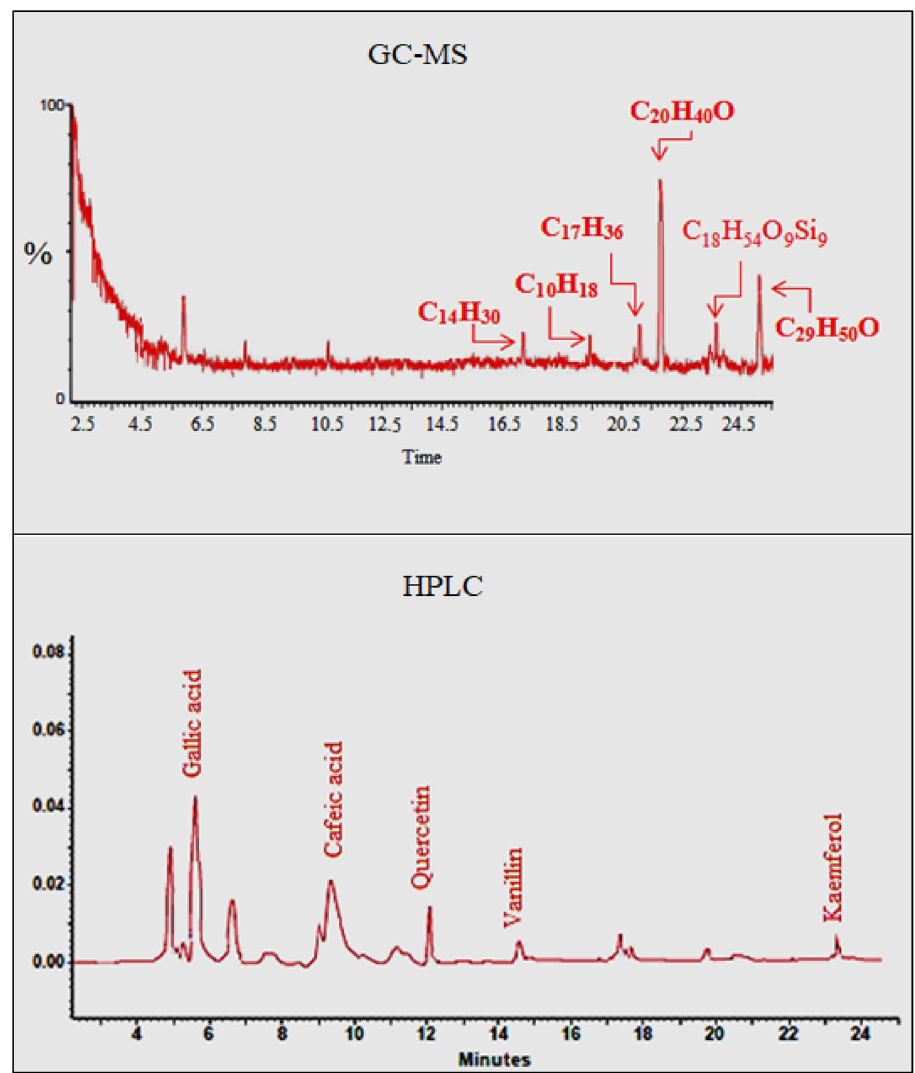
Figure 2. GC–MS and HPLC spectrum of A. lividus extract. C 14 H 30 : tetradecane, C 10 H 20 : cyclodecane, C 17 H 36 : heptadecane,